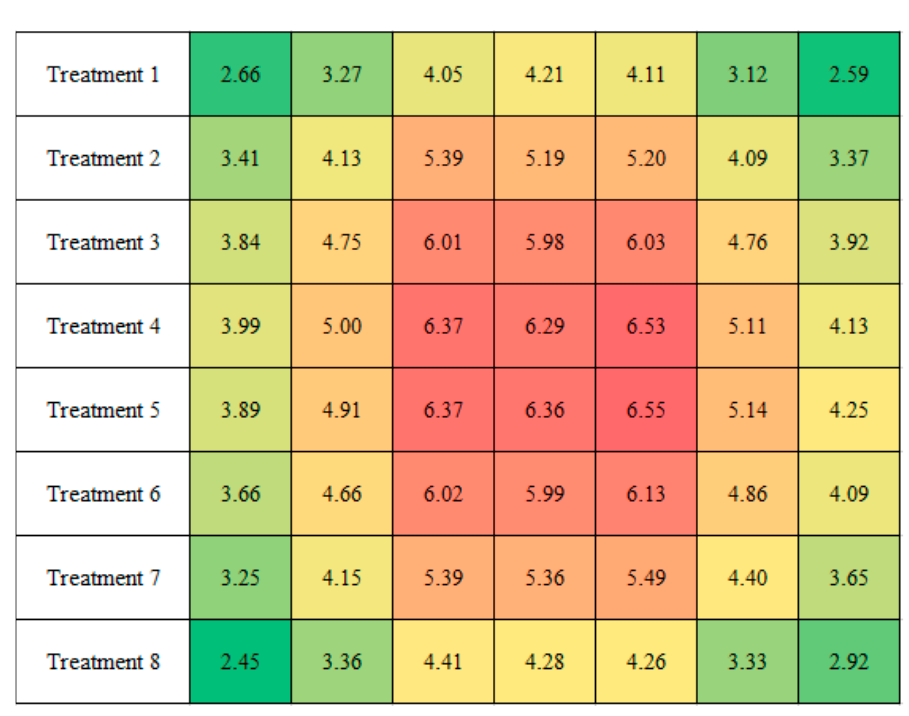
Figure A5. Map of UV light intensity (irradiance) measurements for UV-C (254 nm) for Treatment 1 to Treatment 8. Each colored grid represents a ~4 × 4 cm area where the UV sensor was in place for measurement. The color gradient green–yellow–red represents increasing UV light intensity. Units: mW/cm 2 .